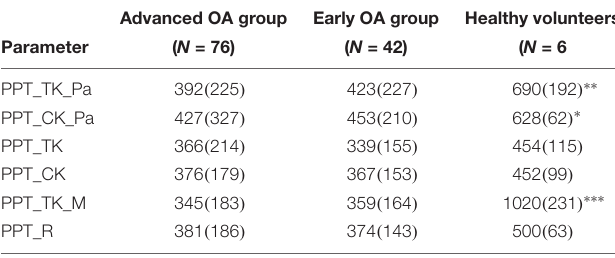
TABLE 2 | Quantitative sensory testing (QST) by pain pressure thresholds (PPTs) in knee OA. Advanced OA group Early OA